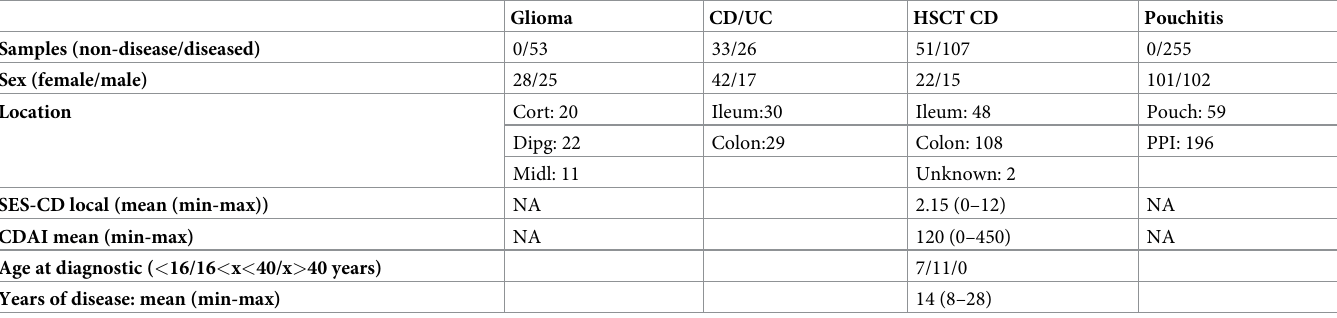
Table 1. Summary of samples and characteristics of the datasets